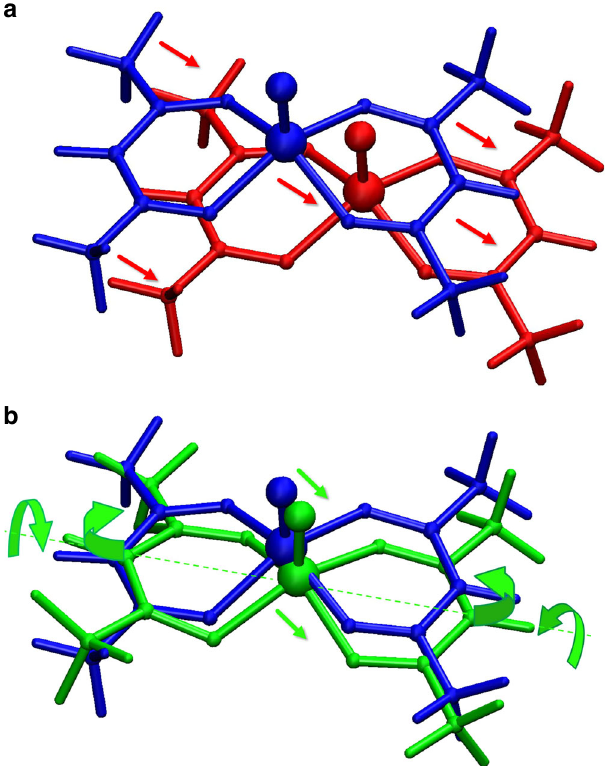
Fig. 7 DFT atomic displacements. a The DFT equilibrium molecular structure (blue ball-and-stick) is superimposed with the distorted one according to the nature of the second transverse acoustic mode along Γ – X at q = (0.145, 0.0, 0.0) (red ball-and-stick, red dashed line in Fig. 6). b The DFT equilibrium molecular structure (blue ball-and-stick) is overlapped with the distorted one according to the nature of the second acoustic mode along Γ – X at q = (0.345, 0.0, 0.0) (green ball-and-stick, green dashed line in Fig. 6). Arrows sketch the small rigid translation of the molecule which is now strongly mixed with the bending of the acetylacetonate ligands and their torsion around the dashed axis.